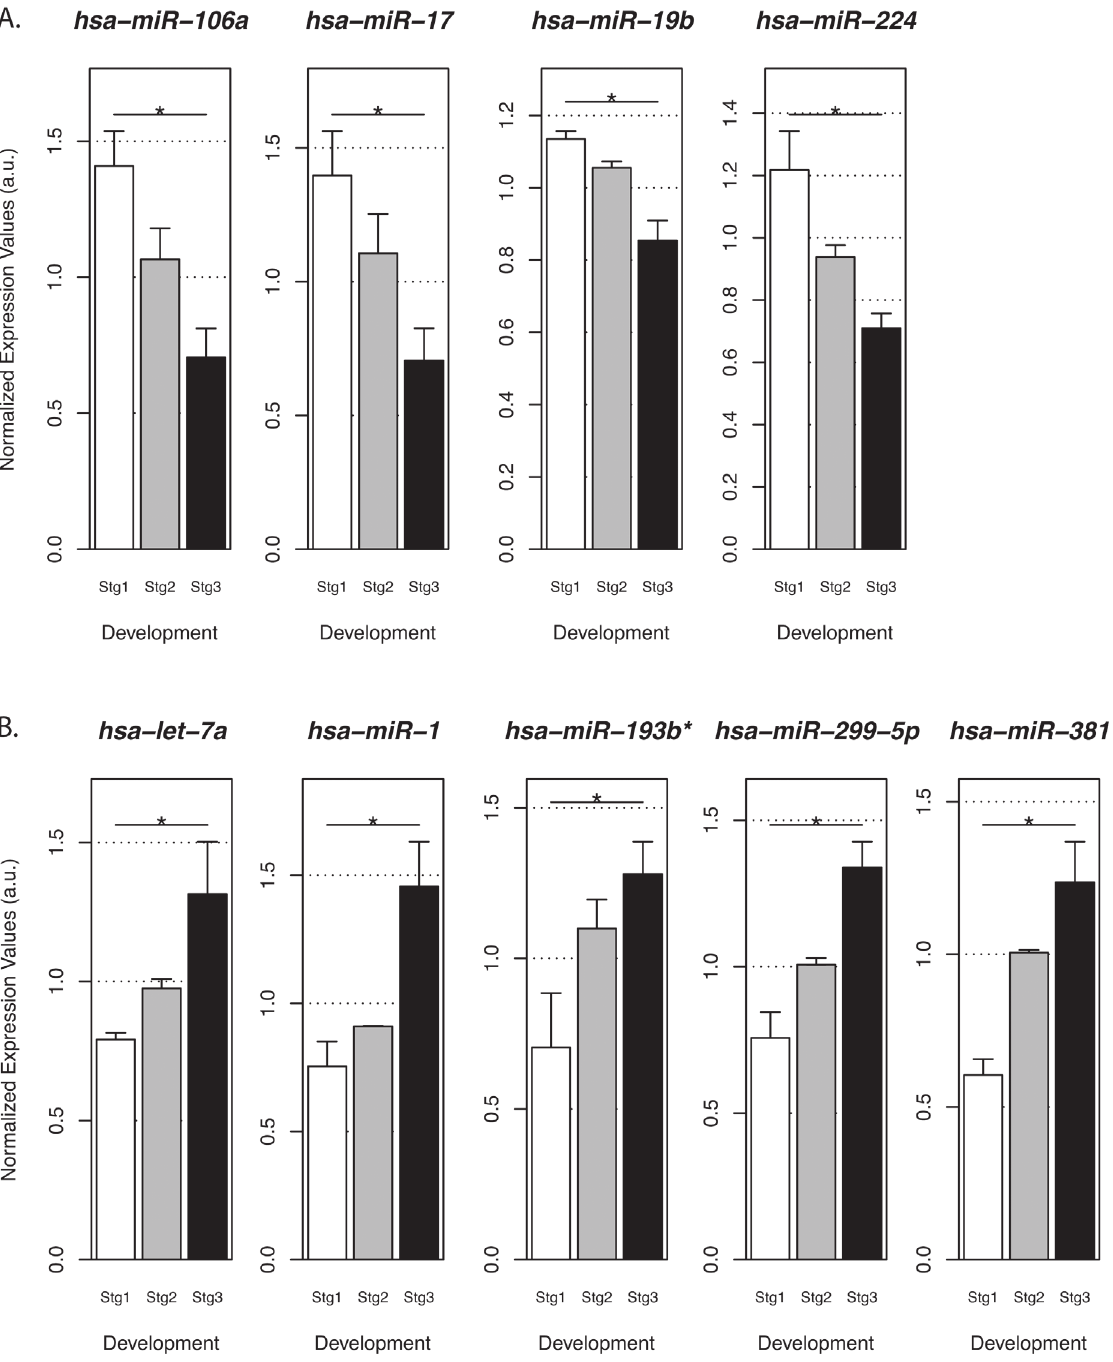
Figure 3. Distinctive patterns of miRNAs expression in human muscular development. Global miRNA expression profiling was performed using control muscle biopsies at 14, 15, 16, 18, 20, 22, 26 and 33 weeks of development. Stg2 (Stage 2, biopsies at 14 – 16 weeks of development) corresponds to secondary muscle fiber formation; trans (biopsies at 18 and 20 weeks of development) is the transition phase between the secondary myogenesis and the maturation phase; and, Stg3 3 (Stage 3, biopsies at 22 – 33 weeks of development) corresponds to the maturation phase. A- down-regulated microRNAs during development; B- up-regulated microRNAs during development ( * P < 0.05; nonparametric one-way ANOVA with 1,000 permutations; compared Stg2 with Stg3).